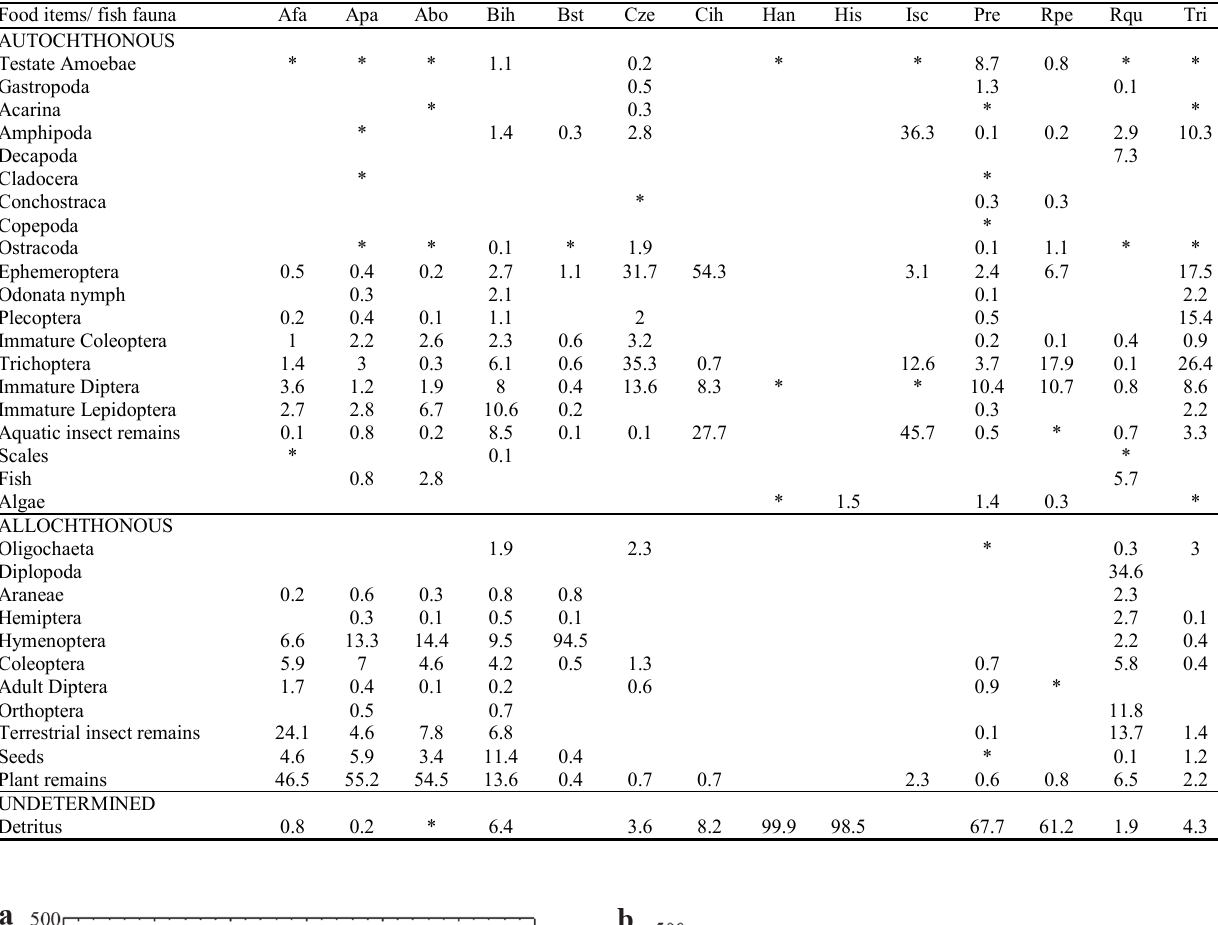
Table 3. Food items consumed by the fish fauna in Itiz stream, Ivaí River basin, Paraná State, Brazil. Values based on data for